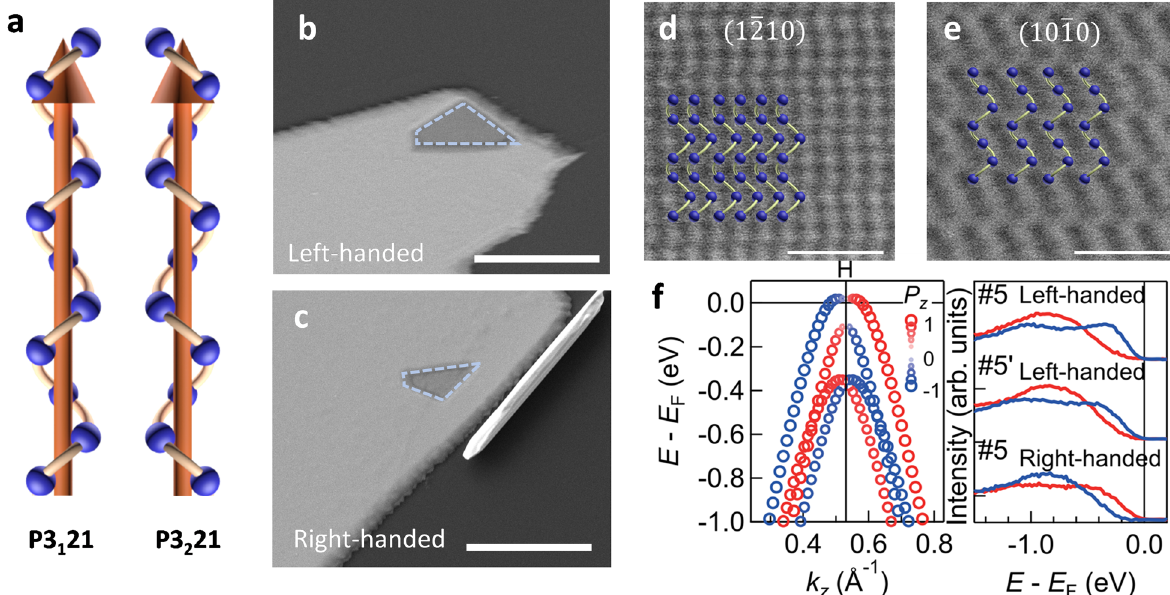
Fig. 6 Chirality and chirality-related properties in Te. a left-handed and right-handed Te helical chains (space group P3 1 21 and P3 2 21) linked by mirror transformation. b , c Asymmetric etching pits on Te surface from hot sulfuric acid etching as a rapid way to identify the chirality of Te. Scale bars: 5 µm. d , e Direct visualization of Te chirality by HRTEM technique from different crystal facets. Scale bars: 1 nm. f Opposite spin textures near the H point in the valence band in left-handed and right-handed Te measured from spin-resolved ARPES. ( f ) is reproduced from ref. 34 .